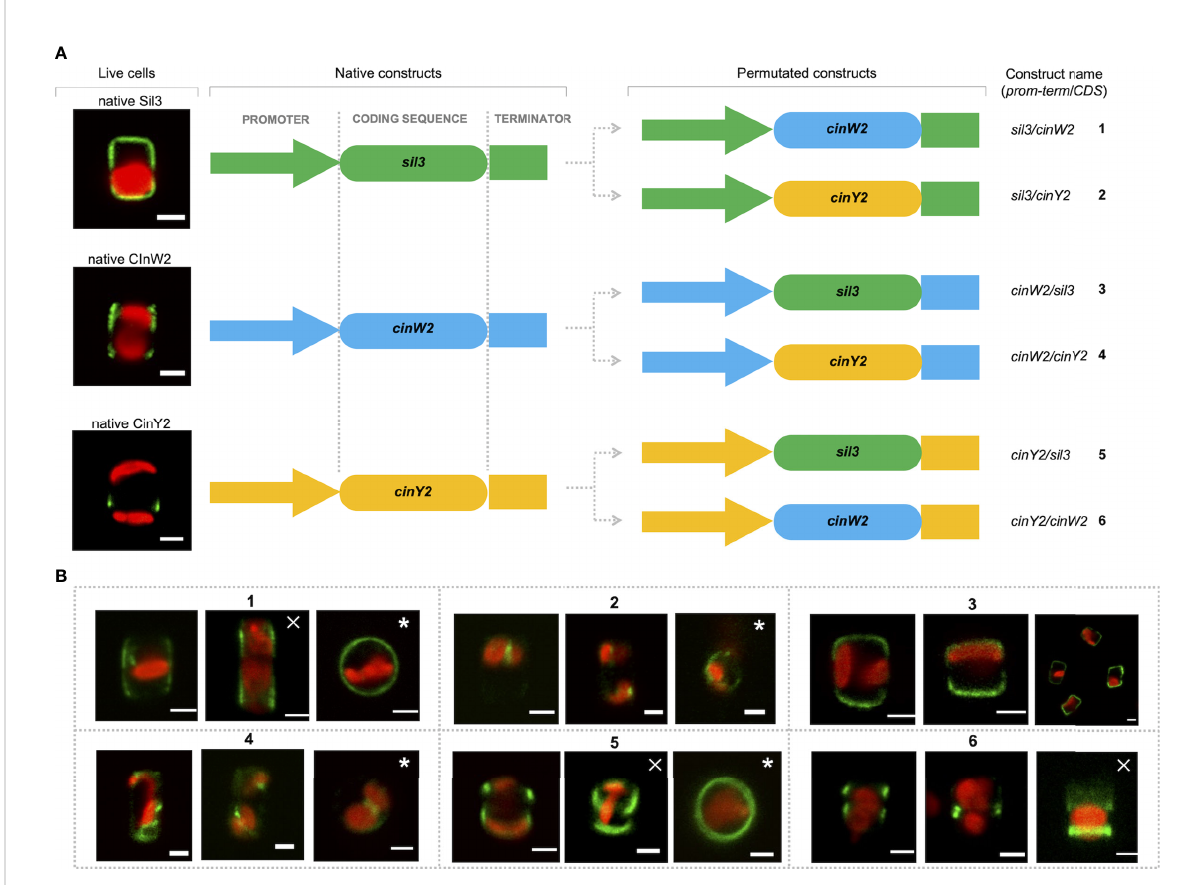
FIGURE 6 Localization experiments with the constructs obtained upon permutation of the regulatory regions between the sil3 , cinW2 and cinY2 genes. (A) shows a graphical depiction of the constructs used for the experiments, highlighting the substitution of the native coding sequences of each gene with the coding sequences of the other two genes, therefore resulting in six new constructs (the position of the egfp coding sequence is omitted for simplicity, as it is the same as in the parental Sil3-eGFP, CinW2-eGFP or CinY2-eGFP constructs). (B) shows girdle band view images (merged eGFP and PAF channels) of live cells selected from in vivo localization experiments performed using the constructs shown in (A) . The images marked with a cross are Z-stack projections; the images marked with an asterisk are in valve view. Scale bars: 2